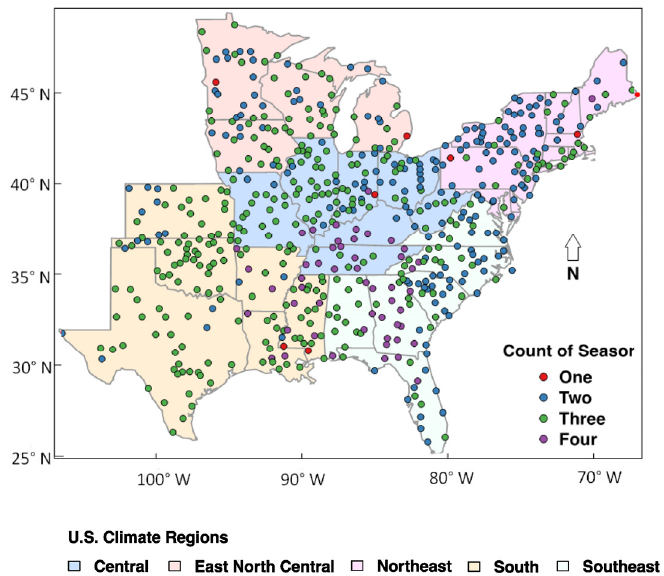
Figure 4. The number of seasonal significant mode of empirical probability distribution function estimates based on the calendar dates of annual maximum daily precipitation. The season considers as a significant mode when the number of significant days is at least twenty days per season. Probability density estimates are assessed for significance based on density estimates using resampled data. A median estimate is obtained from the ensemble of distributions resulting from bootstrap resampling ( N = 1000). Bandwidth for the kernel density estimates is evaluated using the likelihood cross-validation method.